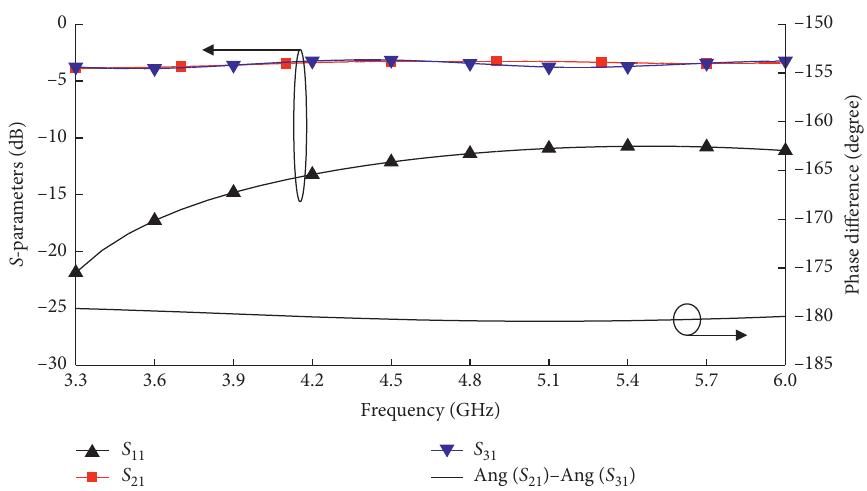
Figure 13: Simulated ( S )-parameters and phase difference of the feeding